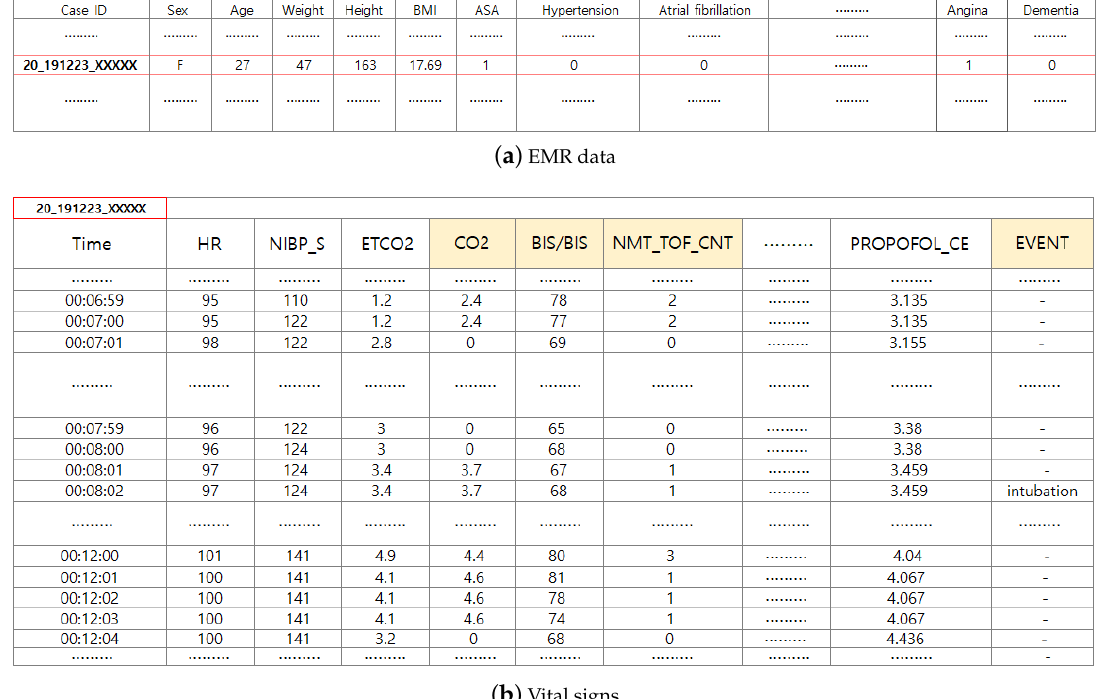
Figure 1. ( a ) Sample EMR data, and ( b ) sample vital signs of a